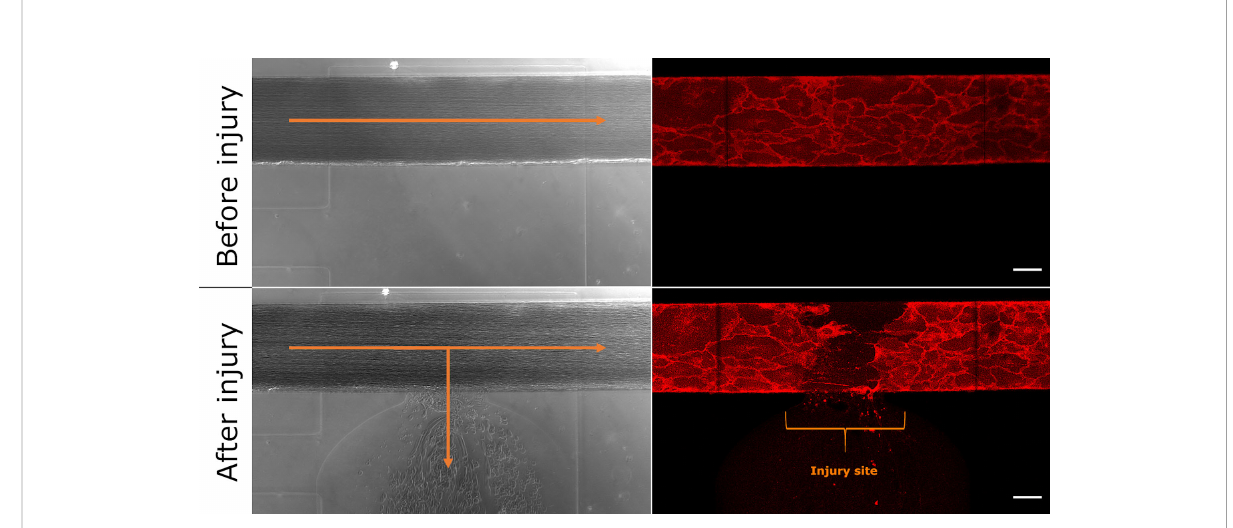
FIGURE 1 Micro fl uidic bleeding model before and after injury. From top left to bottom right: Bright fi eld and CellMask-stained images of the uninjured and injured vessel. The collagen pouch adjacent to the vessel is used to introduce the vessel injury. The blood then fl ows into the collagen container. Blood fl ow is indicated with orange arrows. The bracket indicates the injury site. Scale bar: 50